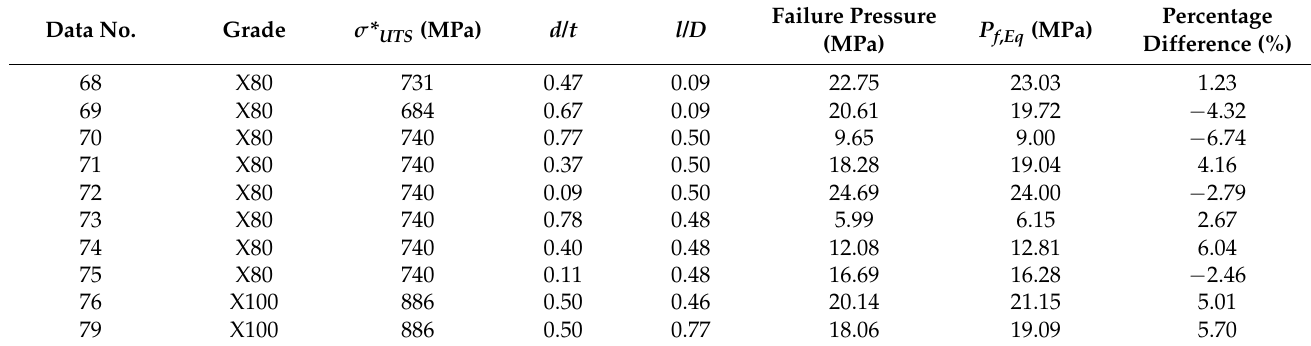
Table 8. Validation of newly developed failure pressure prediction method against actual full-scale burst tests for high-grade pipes subjected to internal pressure only, data from [32].